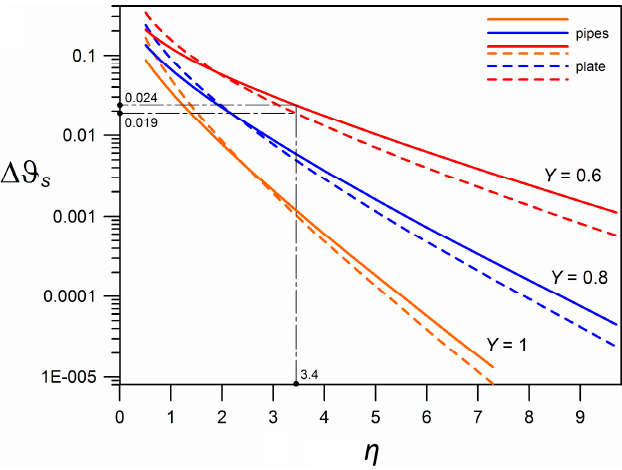
Figure 8. Comparison of dependencies (16) and (19).